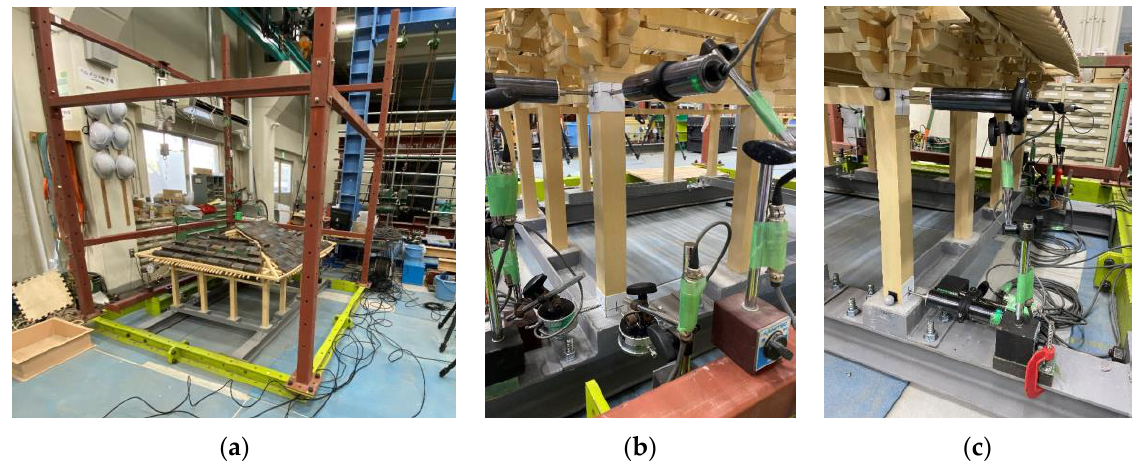
Figure 8. ( a ) Experimental setup, ready for completed image. ( b , c ) Dial gauge setting position. The vertical load was applied using a 1 kg iron block (100 mm × 50 mm × 25 mm), and the number of iron blocks (Figure 9b) used per square meter was calculated according to the roof area. The iron blocks were placed manually before the experiment started and unloaded at the end of the experiment in preparation for the next vertical load parameter.